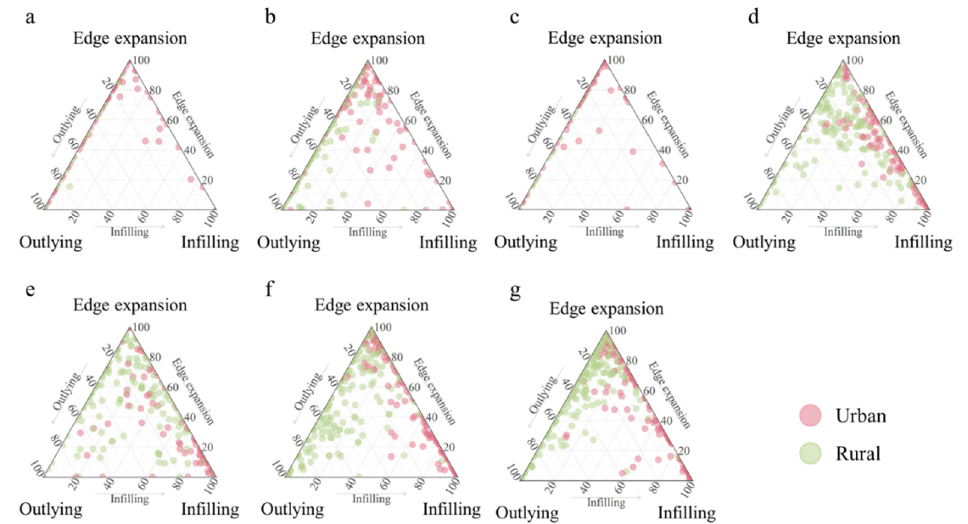
Figure 7. The changes in expansion morphology in the urban and rural areas at the subdistrict level in